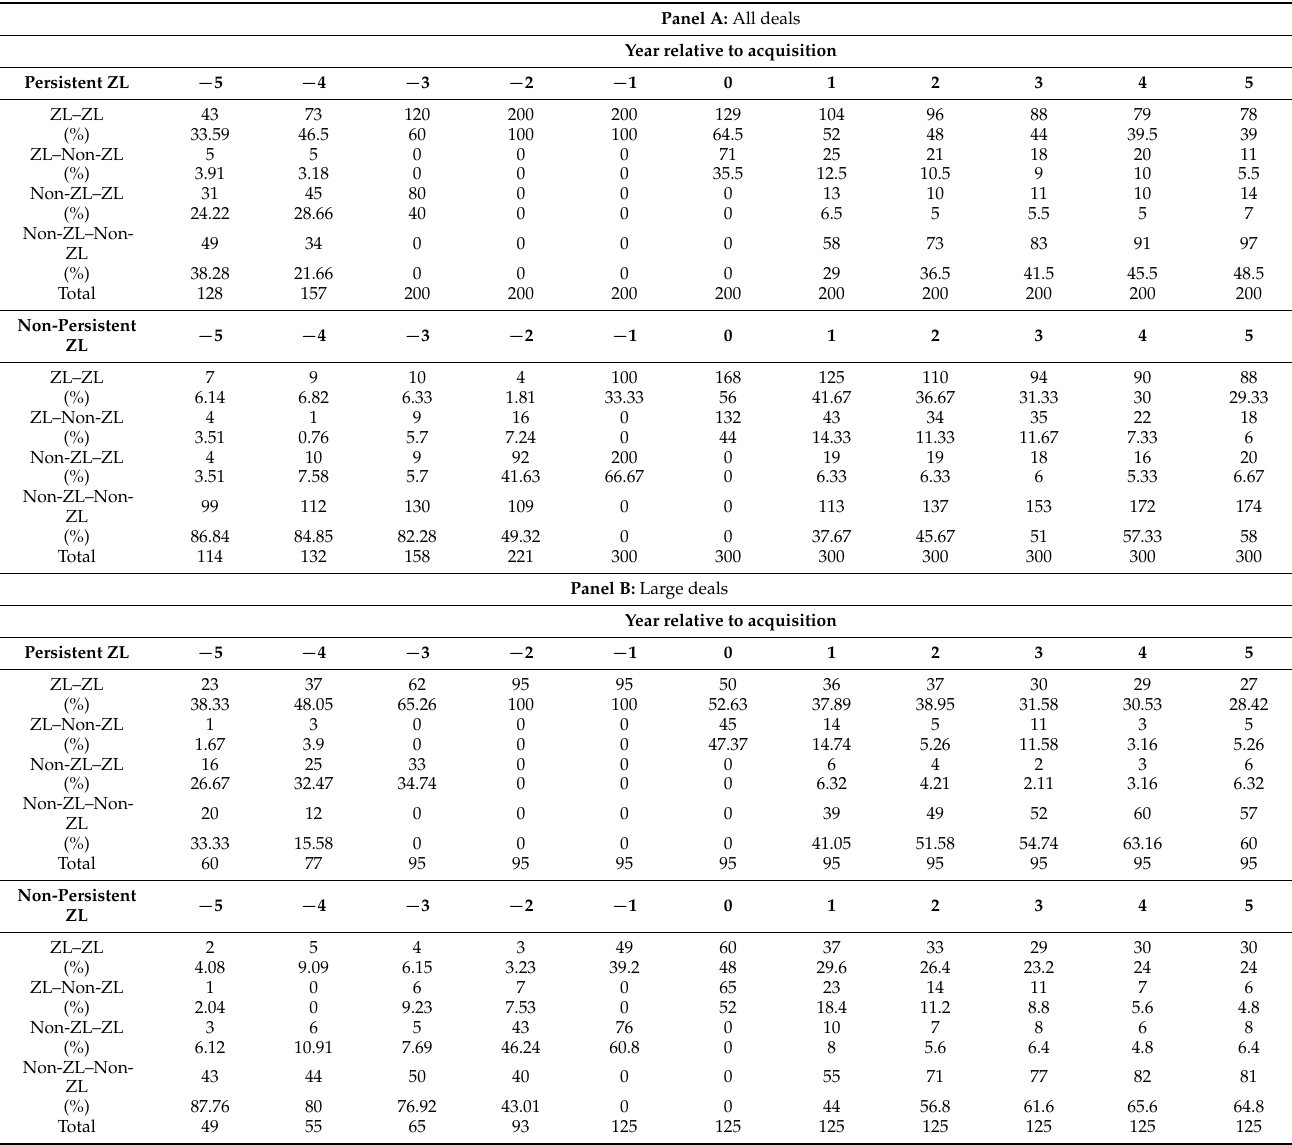
Table 9. Year-to-year ZL status transitions around acquisitions by ZL acquirer. This table presents the number (proportion) of firms transiting from ZL (or non-ZL) in the previous year to ZL (or non-ZL) in the current year for the acquirers which are ZL as of the fiscal year that includes the announcement date of acquisition (i.e., year 0). Results are only presented for acquisitions in which the acquiring firm remains in Compustat from years − 1 to +5 around the acquisition year. Panel A and B report the ZL status transition rates for all acquisition deals and large deals, respectively. Large deals are defined as acquisition deals whose relative size of the market value of the target’s assets to the acquirer’s assets is at least